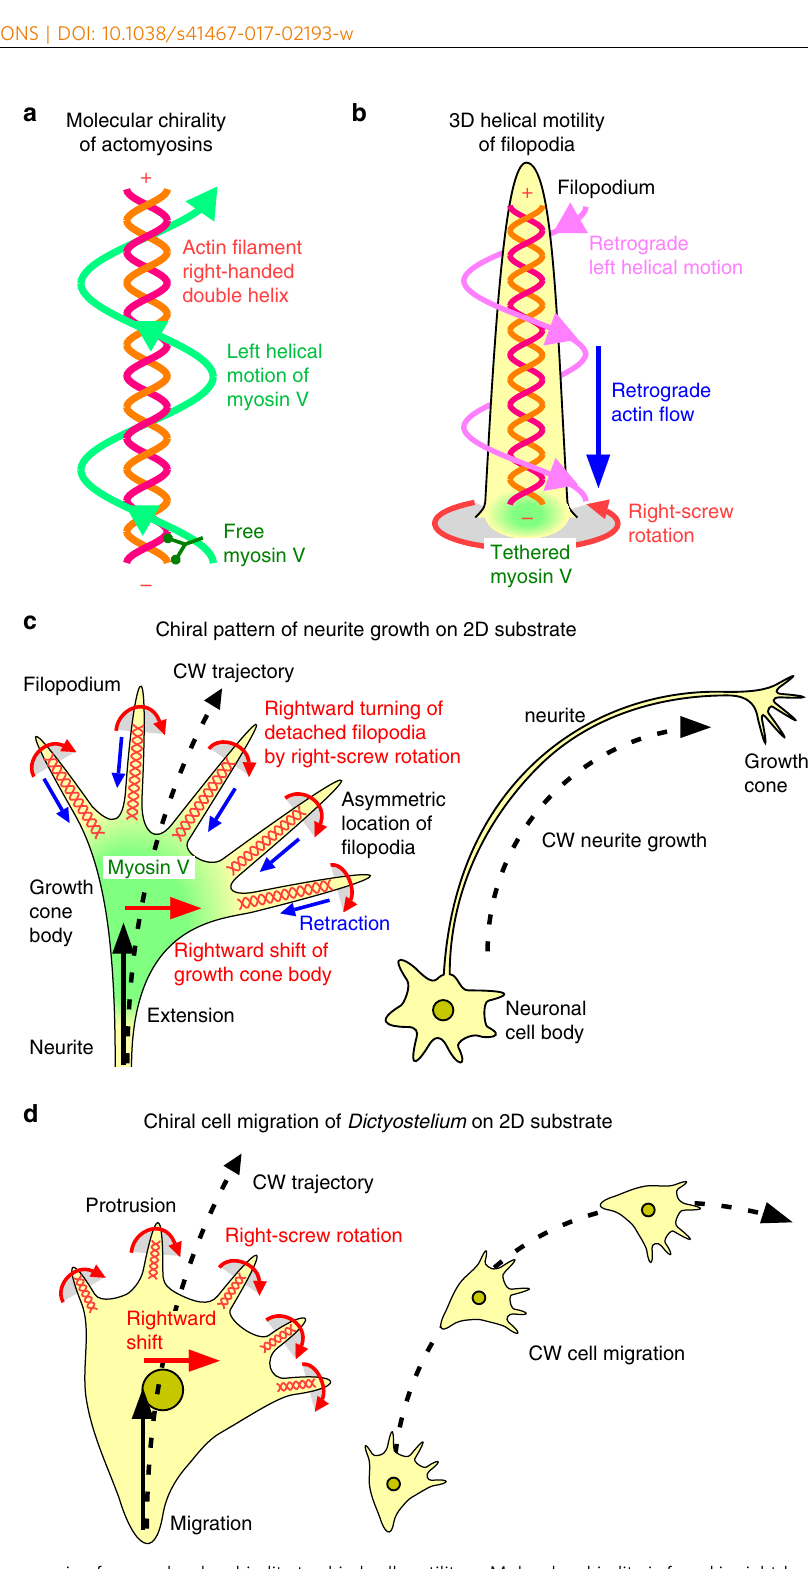
Fig. 8 Schematic model of conversion from molecular chirality to chiral cell motility. a Molecular chirality is found in right-handed double helical structures of actin fi laments and plus end-directed left-spiral motion of myosin V along actin fi laments 49 . b In neuronal growth cone fi lopodia, actin fi laments are enriched and polarized 51 . Myosin V is located at the base of fi lopodia 50 . We have revealed 3D left-helical motion of fi lopodia. The tethered myosin V would generate the left-helical motion by pulling back actin fi laments and rotating them in the right-screw direction. c On 2D substrates, fi lopodia that are detached from substrates would rotate and attach to the substrates again on the right side. Rightward-biased asymmetric location of fi lopodia causes rightward traction of growth cone body 6 . As a result, neurites show clockwise growth 5,6 , which was quanti fi ed in the present study. d We have revealed that Dictyostelium cell protrusions including actin-rich fi lopodia rotate in the right-screw direction, though responsible myosin motor is yet unknown. As in the case of growth cone, on 2D substrates, the right-screw rotation of protrusions would generate rightward shift of the cell body. This shift would cause clockwise cell migration, which was demonstrated in this